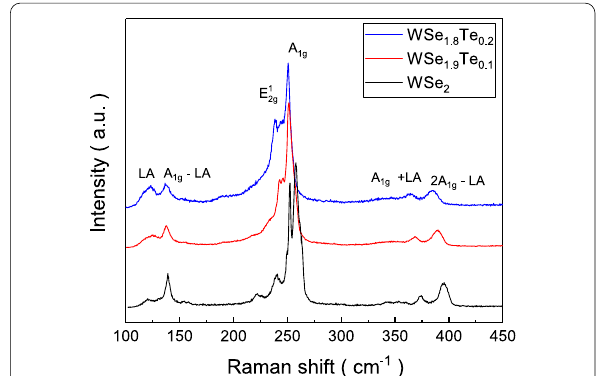
Fig. 2 The Raman spectra of the WSe 2 , WSe 1.9 Te 0.1 and WSe 1.8 Te 0.2 single crystals. Peaks shift to lower Raman shift in samples with more Te atom replacement